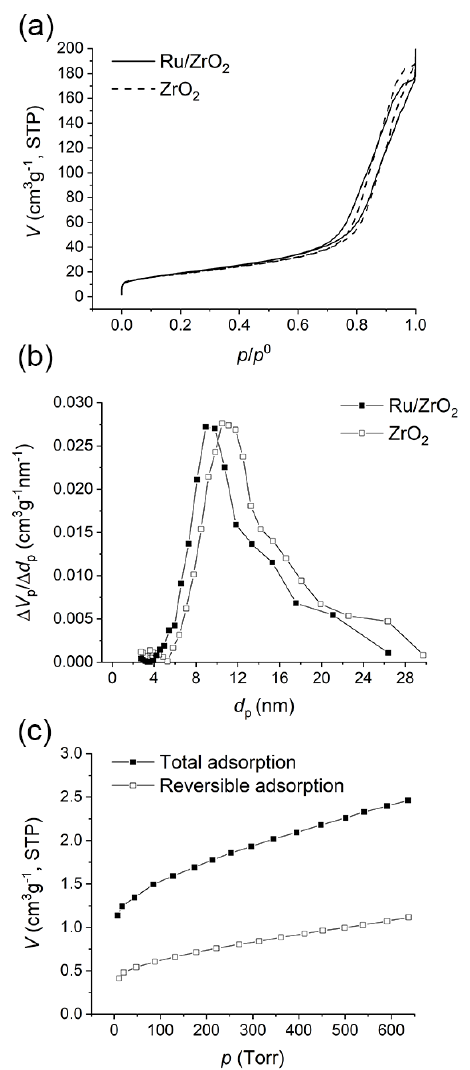
Figure 1. ( a ) Nitrogen physisorption isotherms at −196 °C, ( b ) the Barrett–Joyner–Halenda (BJH) pore size distribution calculated from the desorption branch 0.2–0.9 p / p 0 and ( c ) the total H 2 chemisorption isotherm ( ■ ) and the reversible H 2 adsorption isotherm (□) measured at 75 °C.